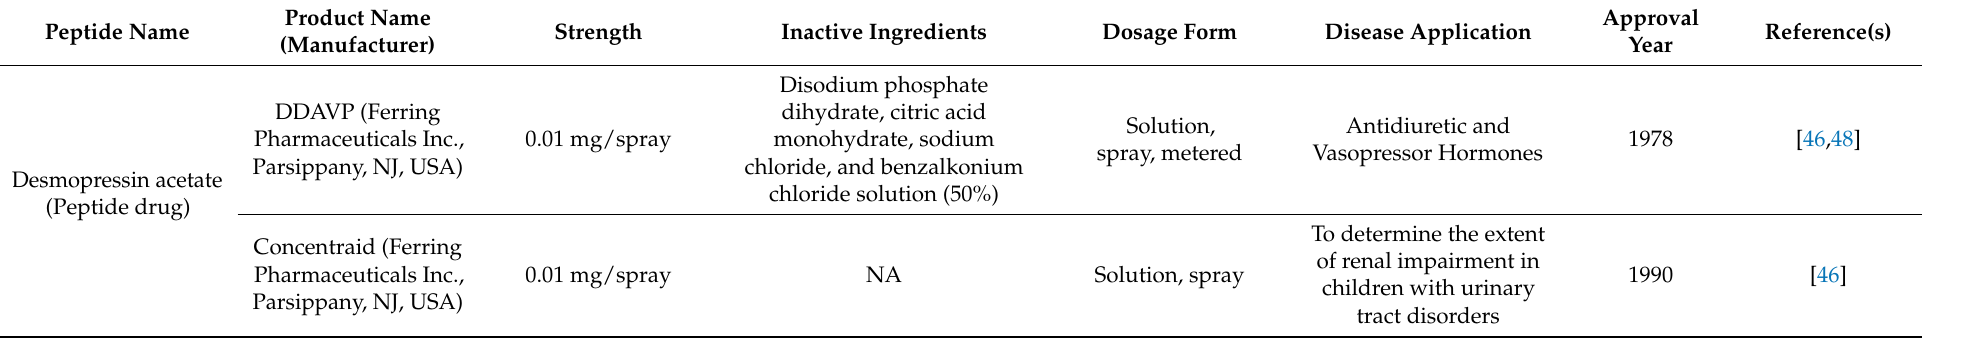
Table 3. A list of intranasally administered high molecular weight drugs including peptides and proteins on the